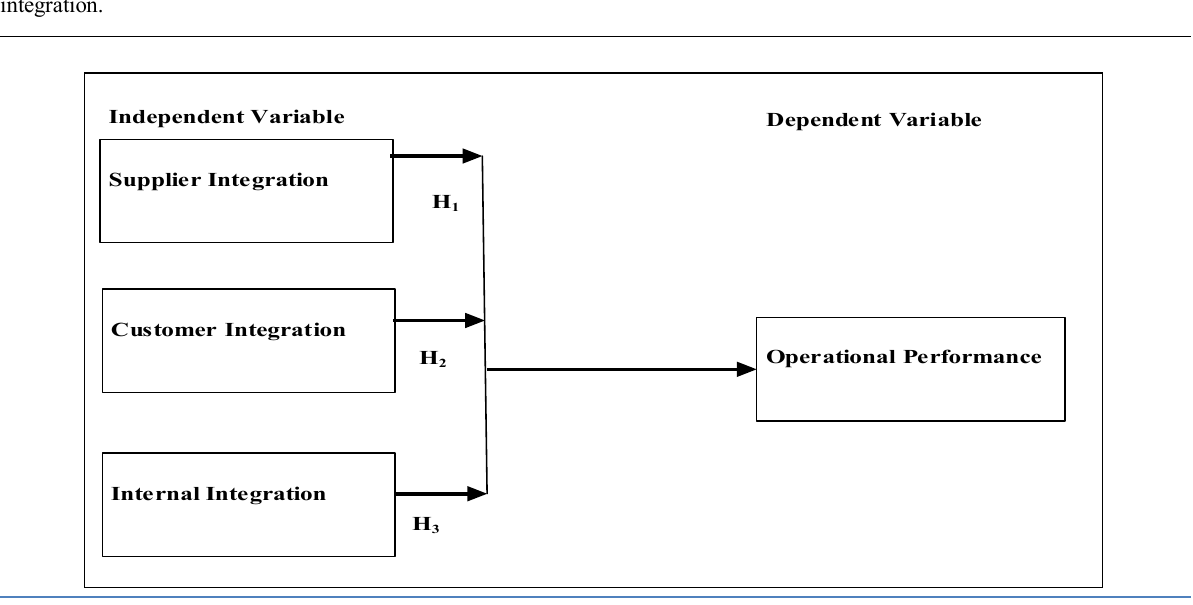
Figure 1: Conceptual